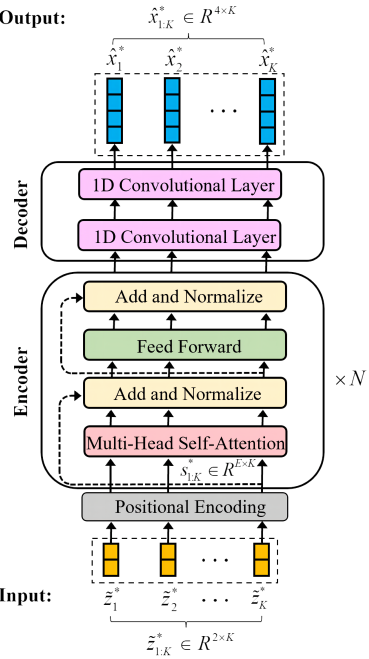
Figure 3. Architecture of the TBN. Input data are normalized observation sequences ˜ z ∗ mapped to s ∗ , whose dimension is E × K by positional encoding. The encoder consists of N-stacked 1: K multi-head self-attention and fully connected feedforward layers, which aim at extracting the features of s ∗ . The decoder maps E -dimensional feature vectors to the normalized state sequence ˆ x ∗ 1: K two 1D convolutional